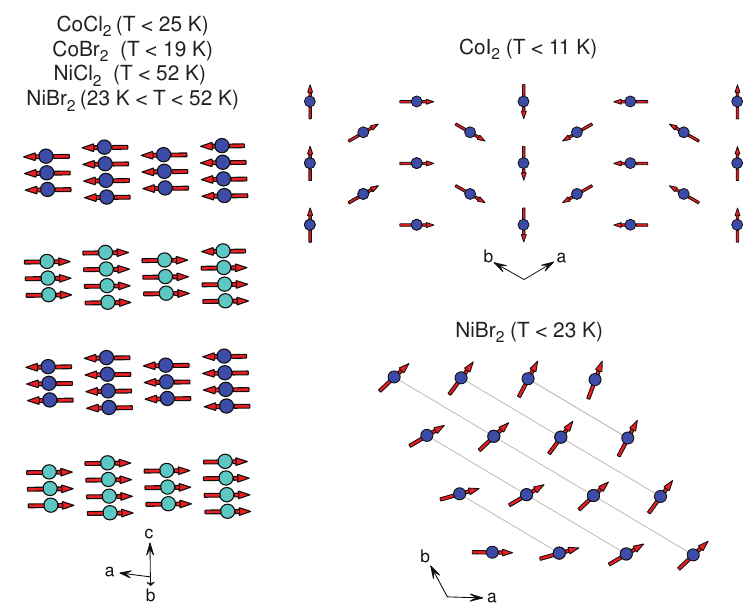
Figure 7. Magnetic structures of Co X 2 and Ni X 2 for X =Cl and Br, and CoI 2 . The moments lie in the plane in each case, and are known to be parallel and antiparallel to the [210] direction in the commensurate structures of CoCl 2 and Ni X 2 . A layer of the commensurate, cycloidal, helimagnetic structure of CoI 2 reported in [41] is shown. A more complex cycloidal structure has also been reported [120]. Only a small portion of one layer of the lower temperature (T<23K) long period helimagnetic structure of NiBr 2 is shown. Coordinate systems of the hexagonal crystallographic unit cells shown for